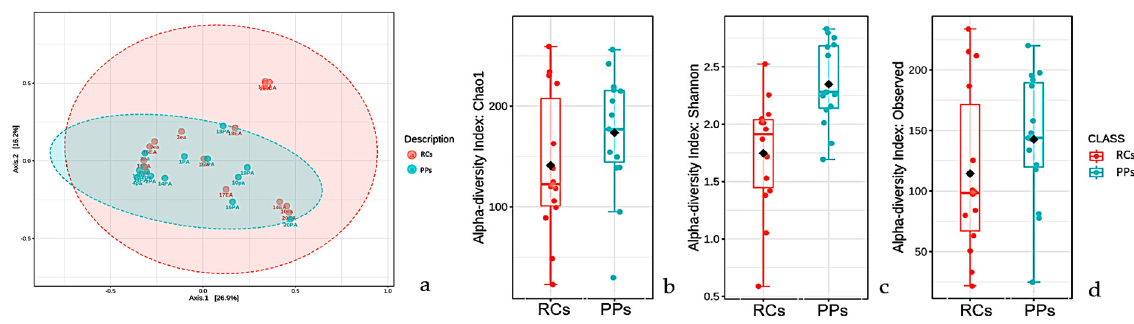
Figure 3. Beta diversity analyzes performed using principal coordinates (PCoA) based on the Jensen-Shannon distances between bacterial communities in the studied conditions ( a ) root canals (RCs) and periodontal pockets (PPs) (ANOSIM, R = 0.3066; p -value < 0.001).( b ) Alpha diversity at the observed level OTUs of RCs (red, n = 12) and PPs (cyan, n = 12) calculated considering the number of observed OTUs (Kruskal-Wallis test, value of p < 0.05). ( c ) Alpha diversity at the level of OTUs in the RCs (red, n = 12) and PPS (cyan, n = 12) calculated using the Shannon index (Kruskal-Wallis test, p value < 0.05). ( d ) Alpha diversity at the level of OTUs in the RCs (red, n = 12) and PPs (cyan, n = 12) calculated considering Chao 1 indices. For each boxplot presented, the graph grids represent the median and the mean, respectively. The lower and upper limits of each box indicate the first and third quartiles, respectively. The lines represent the lowest and highest values within the 1.5 interquartile range (IQR).